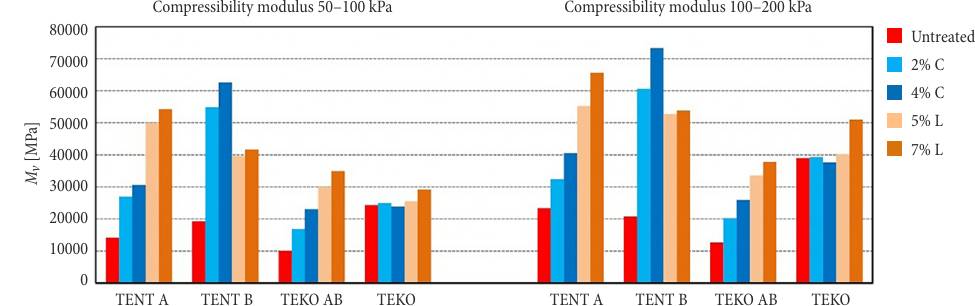
Fig. 8. Compressibility modulus of tested materials after 28